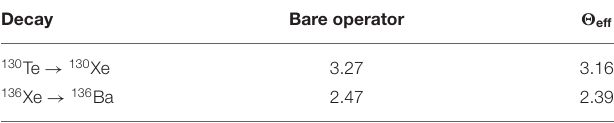
TABLE 2 | Calculated values of M 0 ν for 130 Te and 136 Xe decay.